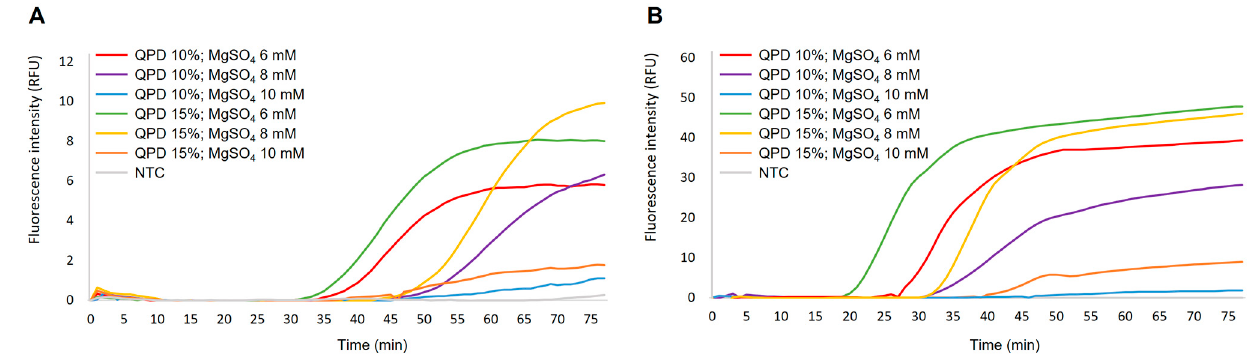
Figure 1. Setting up simplex DARQ-LAMP assays. ( A ) Schistosoma mansoni DARQ-LAMP. ( B ) Strongyloides venezuelensis DARQ-LAMP. Evaluation of 15% and 10% percentages of quencher probe duplex (QPD) in relation to the total amount of unlabeled FIP and different supplementary MgSO4 concentrations (4, 6 and 8 mM) to obtain final MgSO4 concentrations of 6, 8 and 10 mM are indicated. NTC, non-template control (ultrapure water instead gDNA); RFU, relative fluorescence units.